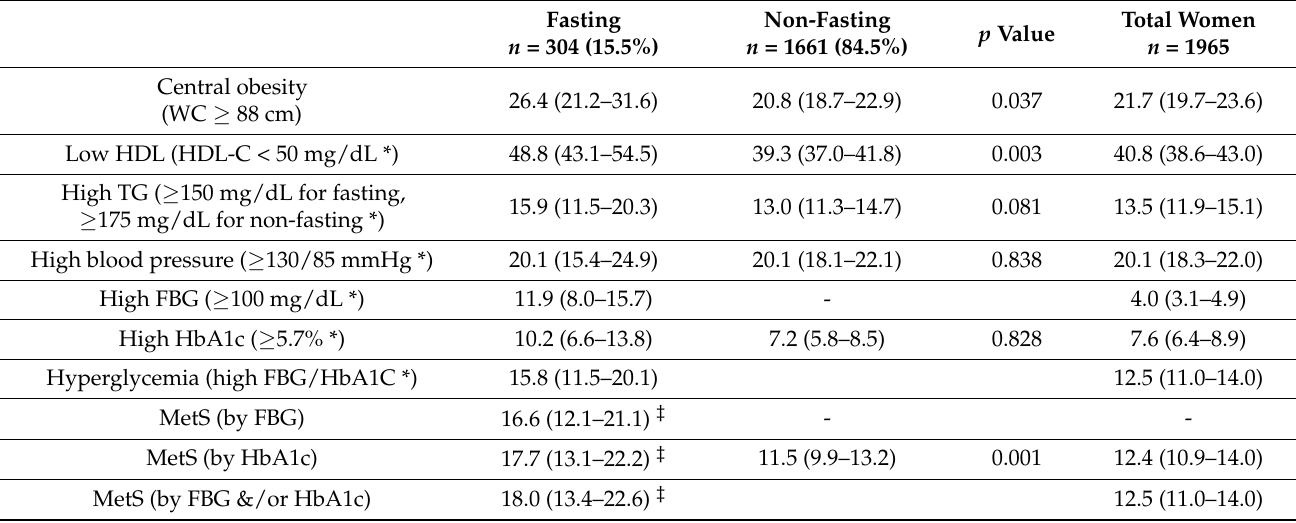
Table 3. Age-adjusted prevalence of metabolic syndrome and its biomarkers in women. Fasting n = 304